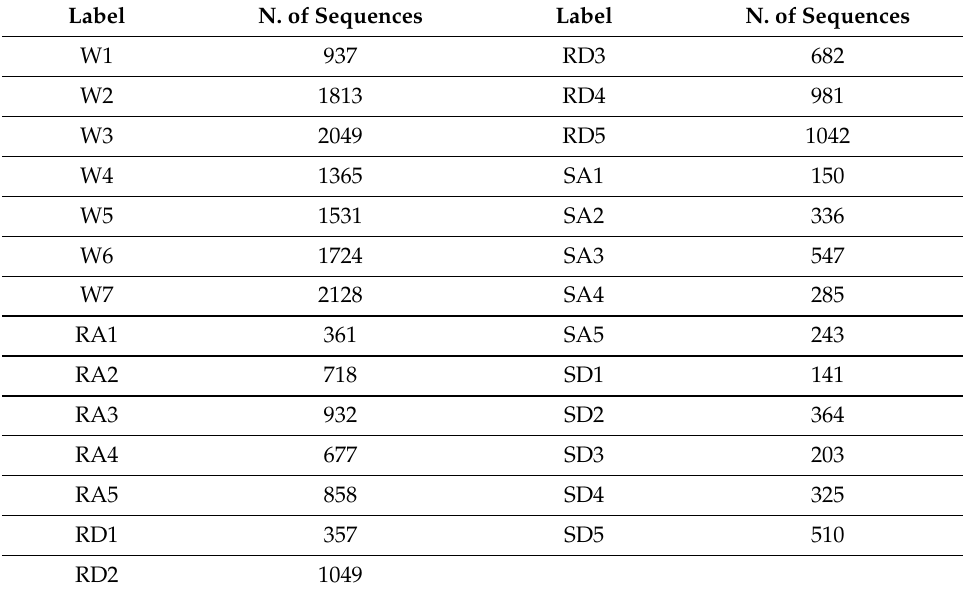
Table 3. Number of sequences for the gait phases in the ENABL3S data-set. W1 corresponds to the gait phase 1 of walking, etc. (see Figure